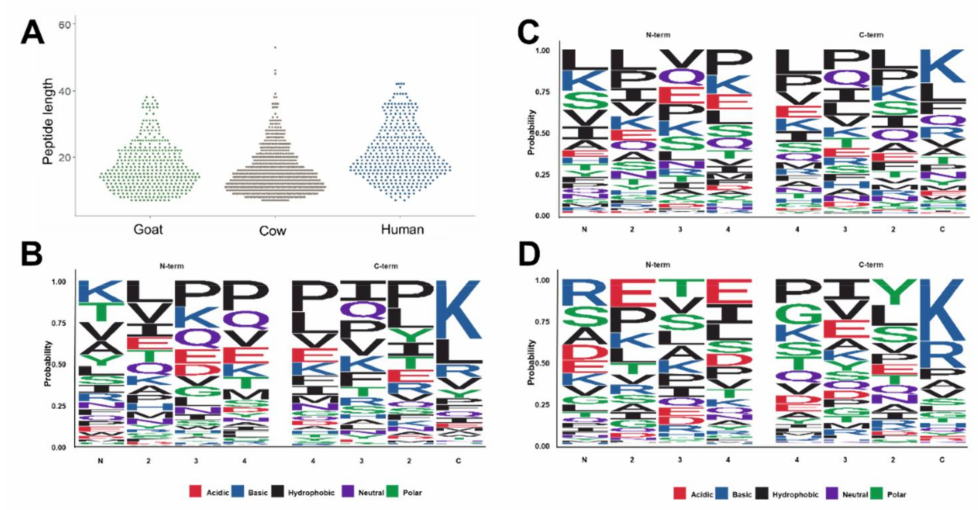
Figure 3. Peptide length distribution for all peptides identified in goat and cow milk-based IF and inhuman milk ( A ). Cleavage patterns for the four N-terminal (residues 1 to 4) and the four C-terminal residues observed in goat ( B ) and cow milk-based IF ( C ) and in human milk ( D ). Cleavage patterns were generated by using ggseqlogo within R